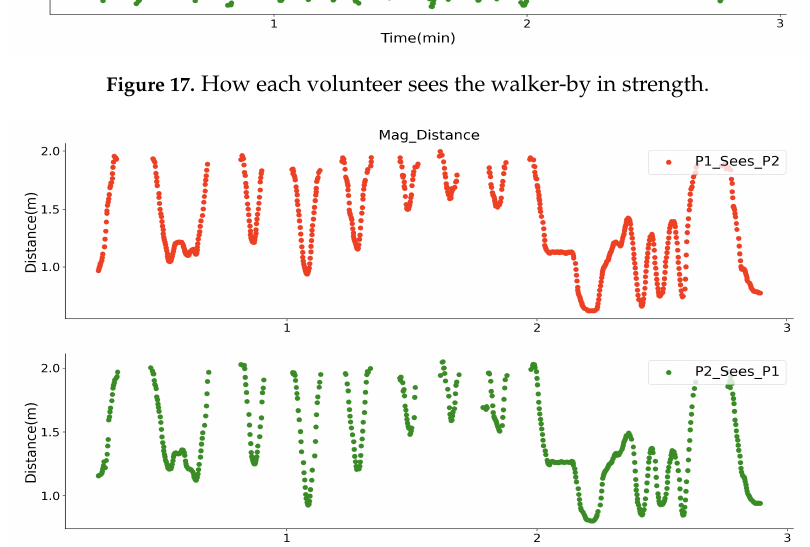
Figure 18. How each volunteer sees the walker-by in